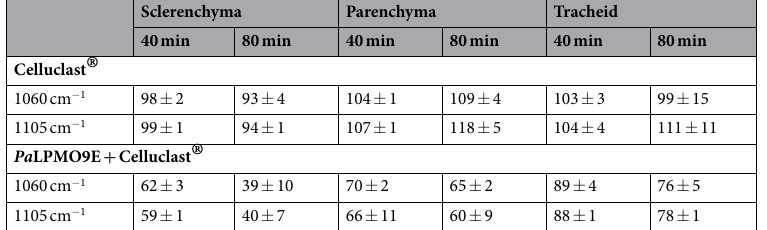
Table 1. Change in FTIR absorbance at 1060 and 1105 cm − 1 of chlorite-treated miscanthus vascular bundle area (sclerenchyma, parenchyma, tracheids) after 40 min and 80 min incubation with Celluclast ® alone or with Pa LPMO9E. Band intensity values are expressed as percent of the intensity measured at the initial recording time. Starting recorded values (20 min) have been normalized at 100 for each